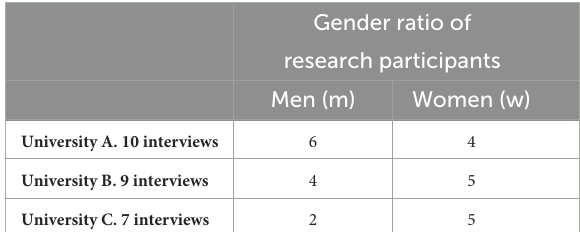
TABLE 1 Research interview data on the three case studies. Gender ratio